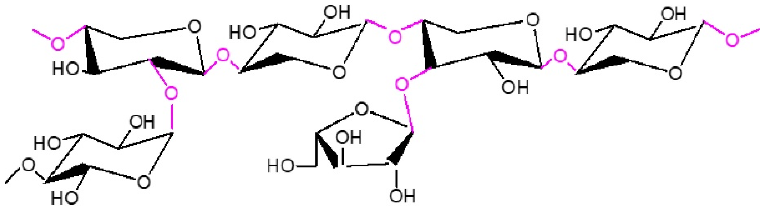
Figure 2. Chemical representation of a hemicellulose chain consisting of xylose and arabinose pentoses [23] (edited).